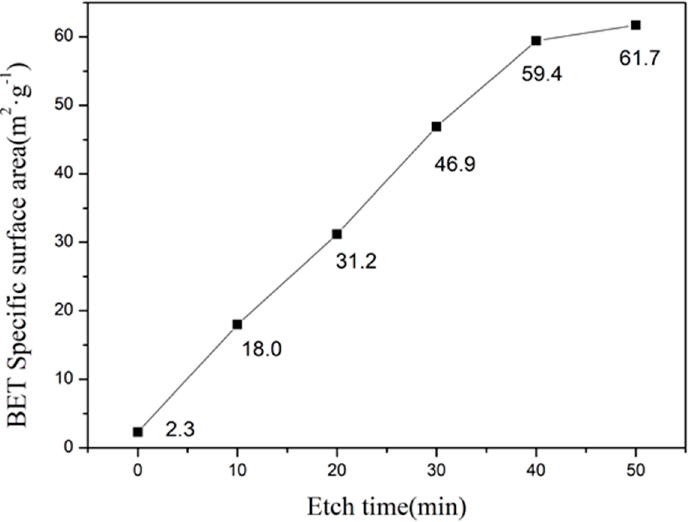
Figure 8. The relationship diagram of BET surface area and etching time.